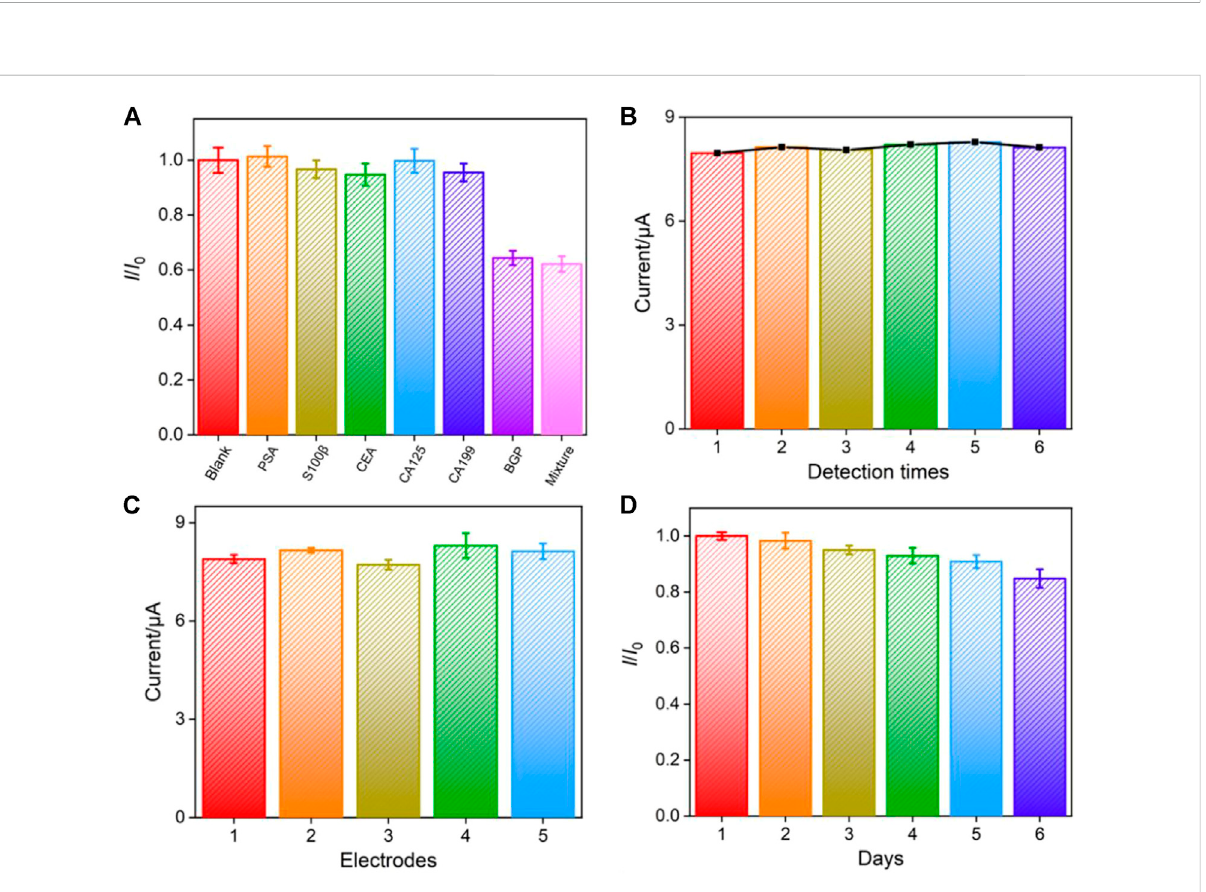
FIGURE 6 (A) Relative ratio of the current ( I/I 0 ) obtained on the developed immunosensors before ( antigen (PSA, 1 ng ml − 1 ), S100 calcium-binding protein β (S100 β , 1 ng ml − 1 ), carcinoembryonic antigen (CEA, 1 ng ml − 1 ), carcinoma antigen